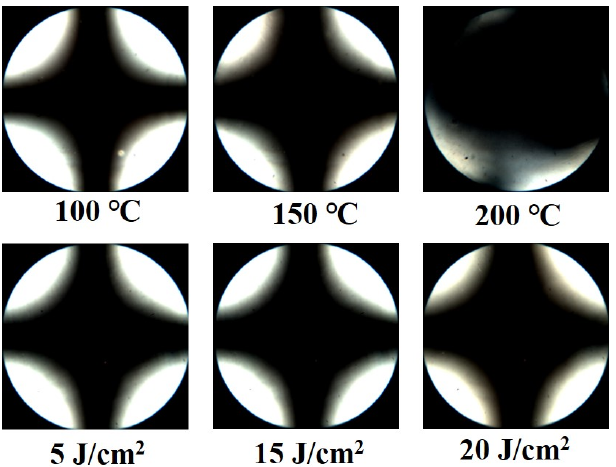
Figure 7. Conoscopic polarized optical microscopy (POM) images of the LC cells made using P2BO films after thermal treatment at 100, 150, and 200 ◦ C for 10 min and UV treatment at 5, 15, and 20 J/cm 2 ,